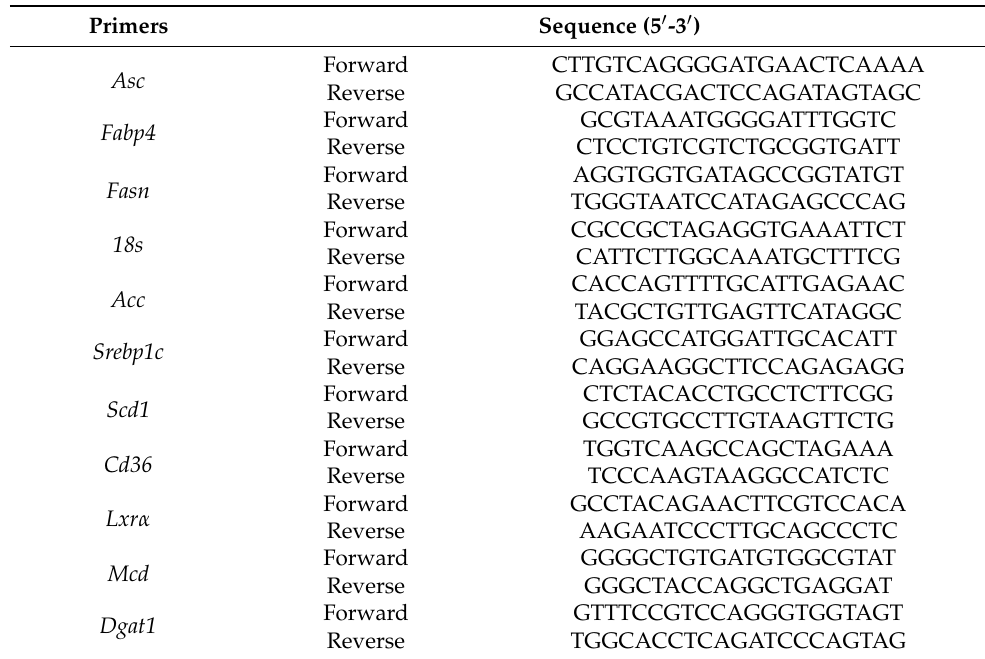
Table 1. Primers for qRT-PCR.